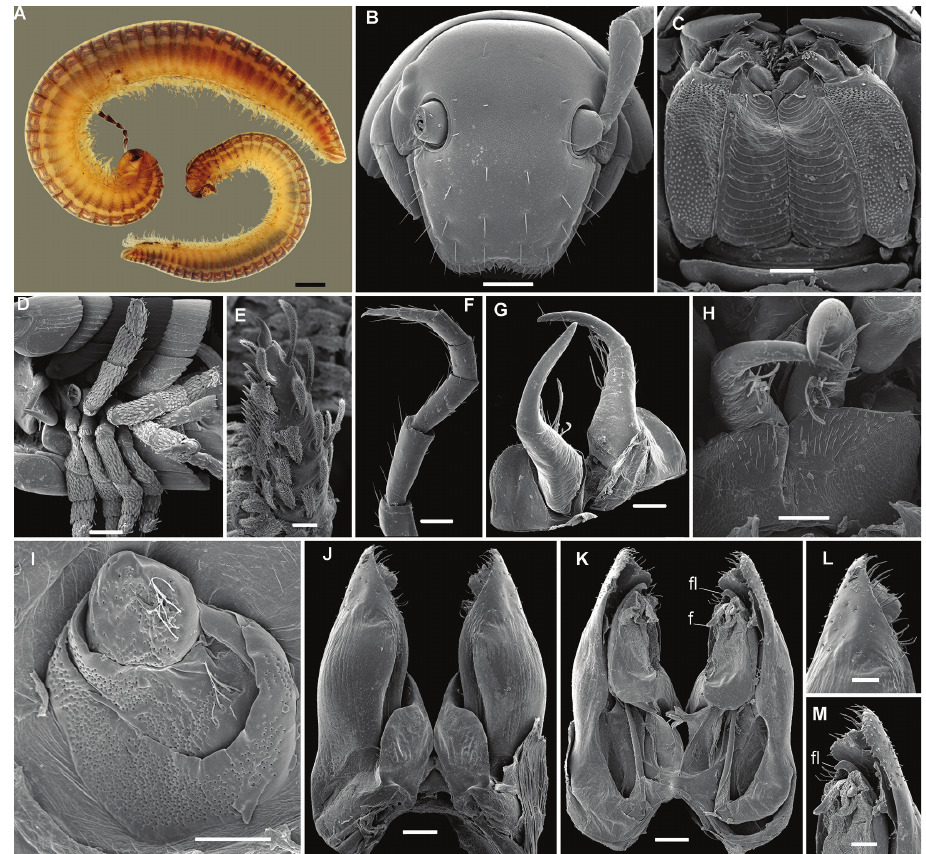
Figure 4. Stemmiulus beroni Mauriès, 1989. A Habituses of ♂ (small specimen) and ♀ (large specimen) B head front view C gnathochilarium D leg-pairs 3 to 7 F first leg-pair (one) G, H leg-pair two, oral and caudal views, respectively I left paragonopod, oral view J, K leg-pair 8 (gonopods) oral and caudal views, respectively L, M apical part of right gonopod oral and caudal views, respectively. Abbreviations : f : flagella, fl : finger-like process. Scale bars 1 mm ( A ), 200 µm ( B, D ), 100 µm (C, F–H, J, K) , 50 µm ( L, M ), 20 µm ( E